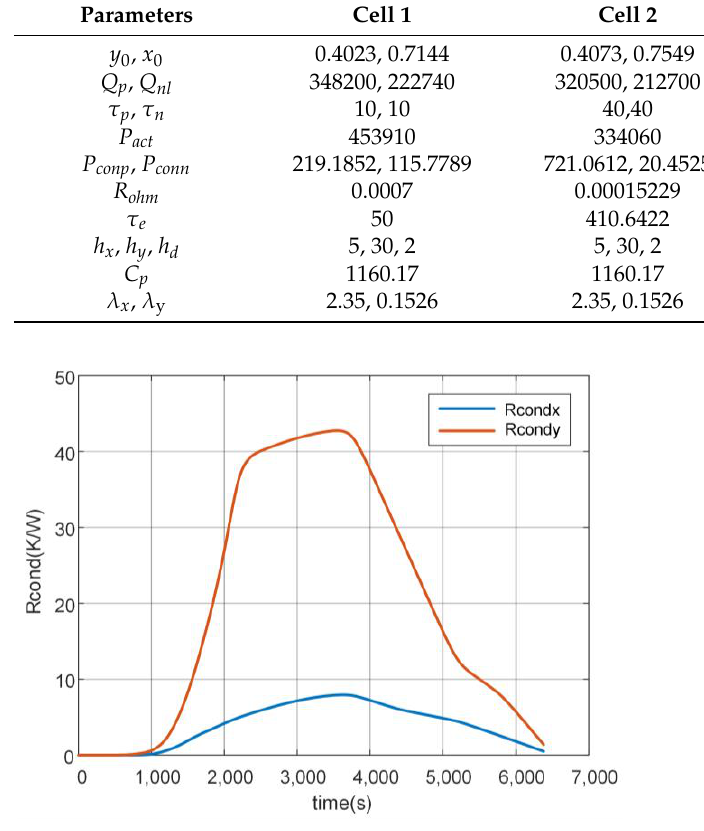
Table 4. Battery parameters.